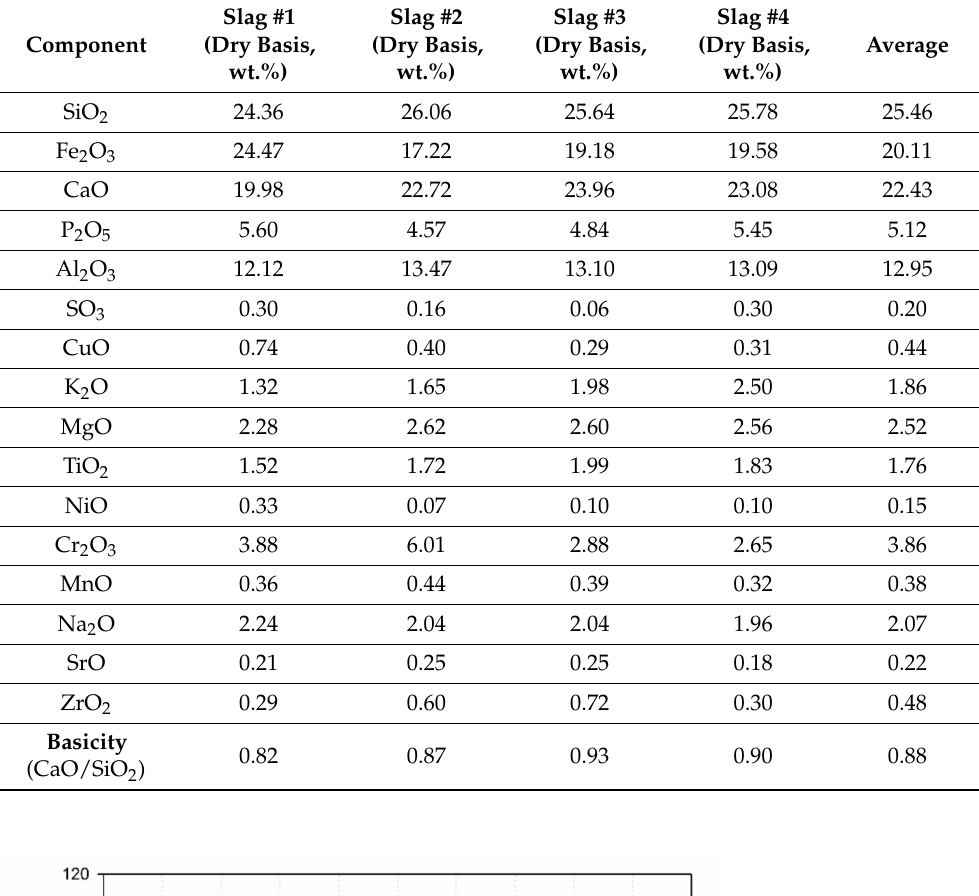
Table 7. X-ray fluorescence analysis results of slag.